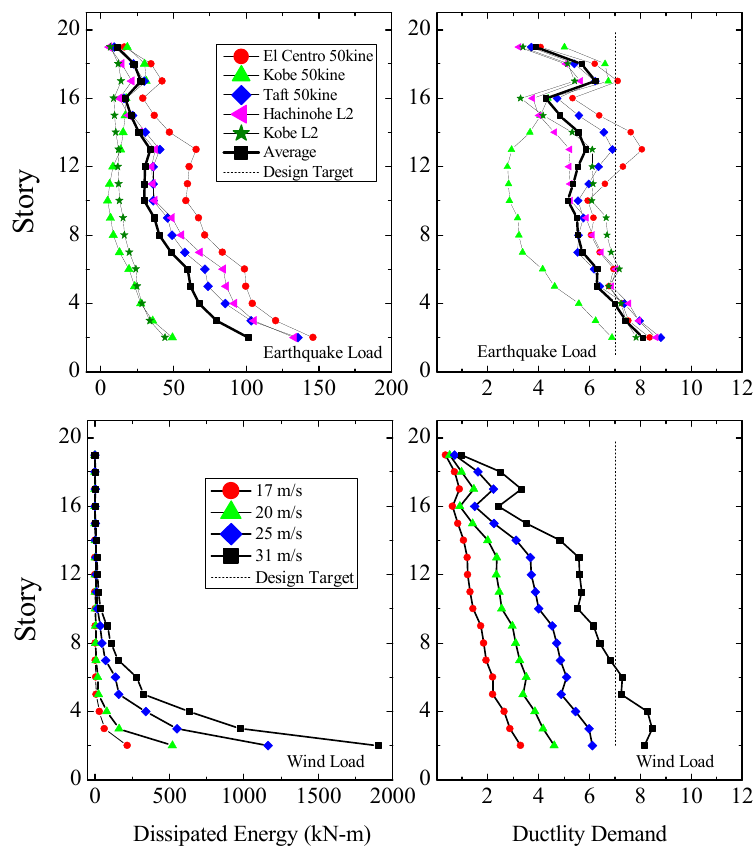
Figure 8. Ductility demand and energy dissipation rate of BRBs along the height of a high-rise steel building under earthquake and wind loads.